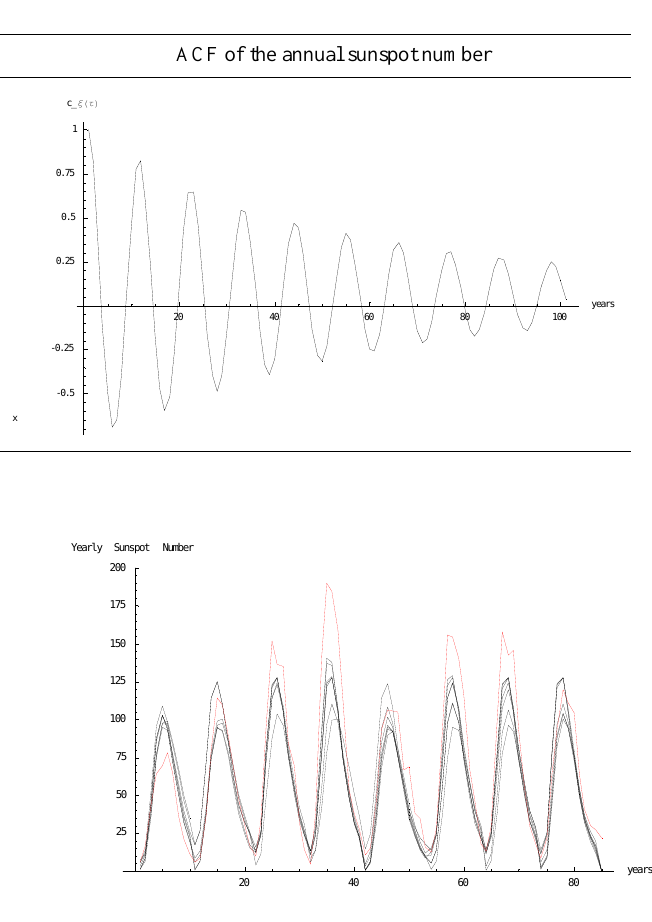
Fig. 14. Auto-regression values γ 23 versus order p for γ ∗ (red line).